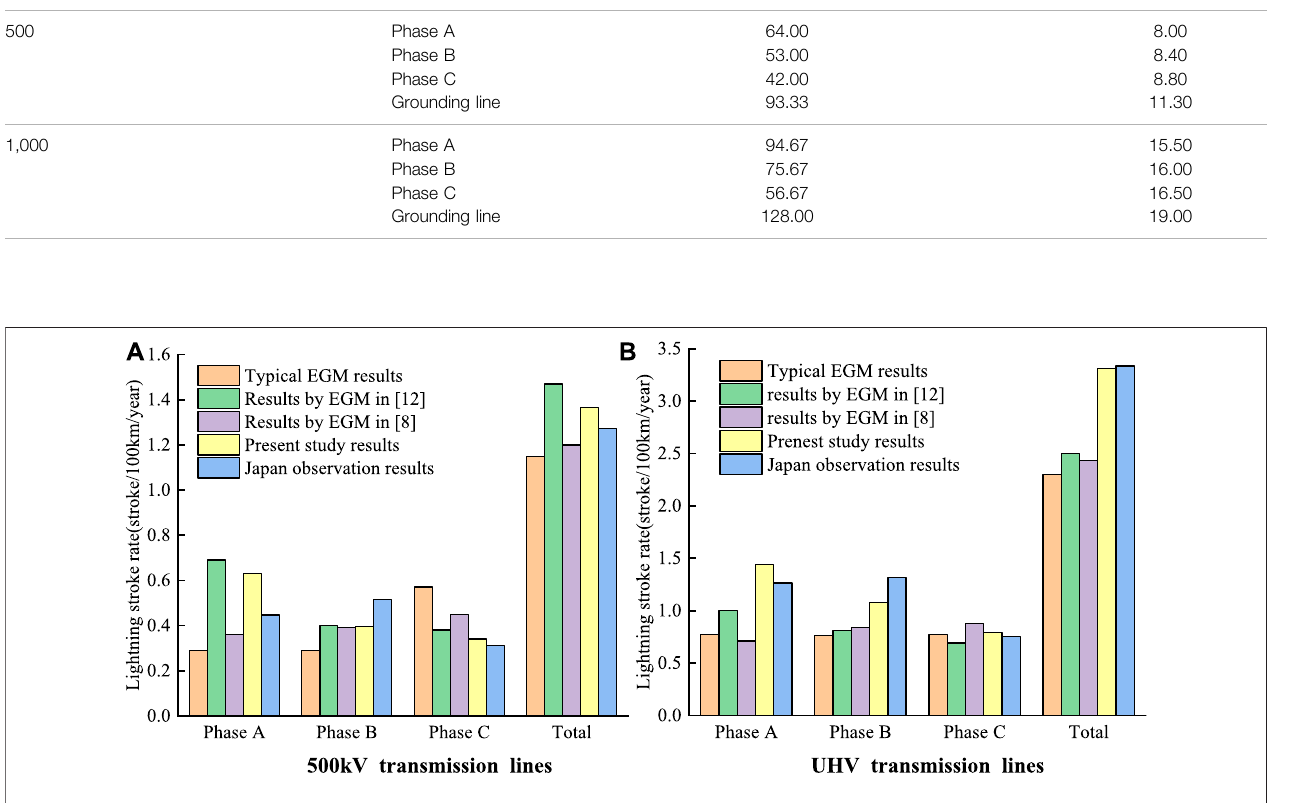
Frontiers in Energy Research |